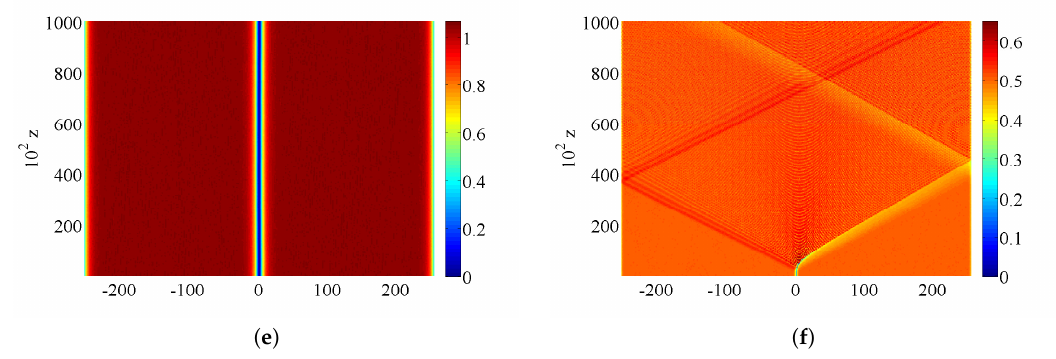
Figure 3. Grey solitons in a 512-waveguide array. ( a ) The imaginary part of the eigenvalues λ (Im( λ )) for different d values; ( b ) The imaginary part of the eigenvalues λ (Im( λ )) for different P values; ( c ) The amplitude of the fundamental solution for grey solitons ( P = 1 and d = 3); ( d ) The intensity of the fundamental solution for grey solitons ( P = 1 and d = 3); ( e ) The evolution of a stable solution for grey solitons ( P = 1 and d = 3); ( f ) The evolution of an unstable solution for grey solitons ( P = 0.5 and d = 0.8).